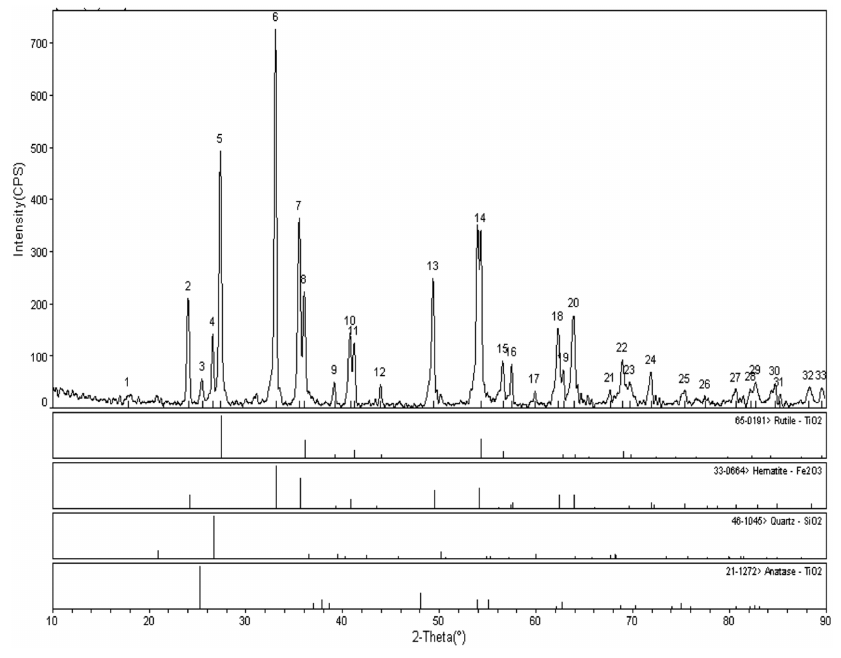
Figure 6: The XRD pattern of the oxidation product treated at 900°C for 30 min from – 80 + 120 mesh